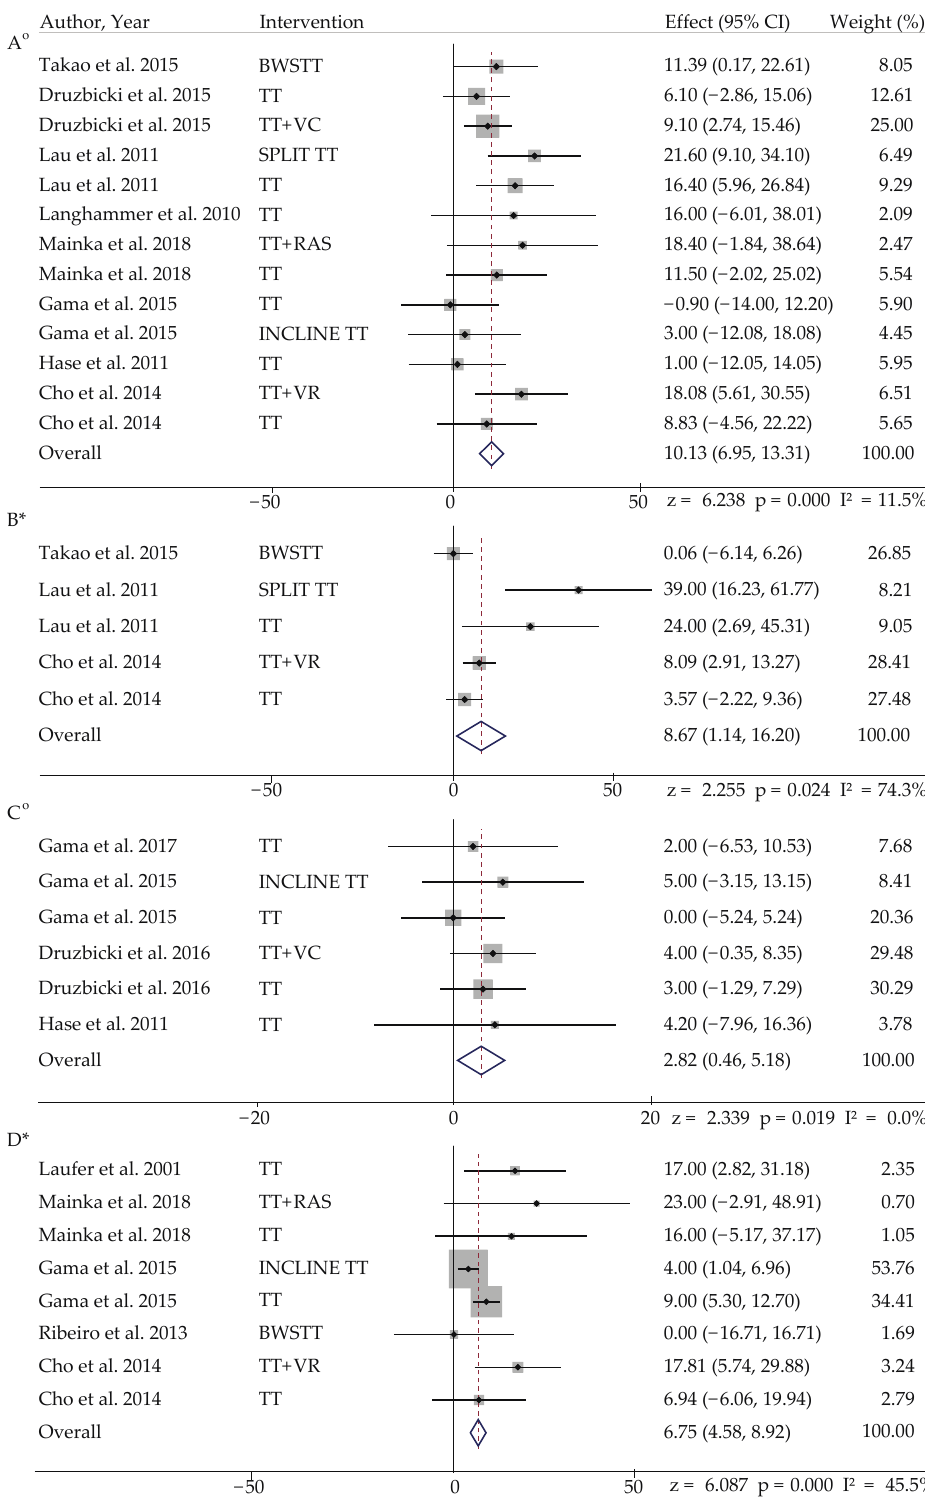
Figure 2. Forest plot of stroke: ( A ) cadence; ( B ) step length; ( C ) step length paretic; ( D ) stride